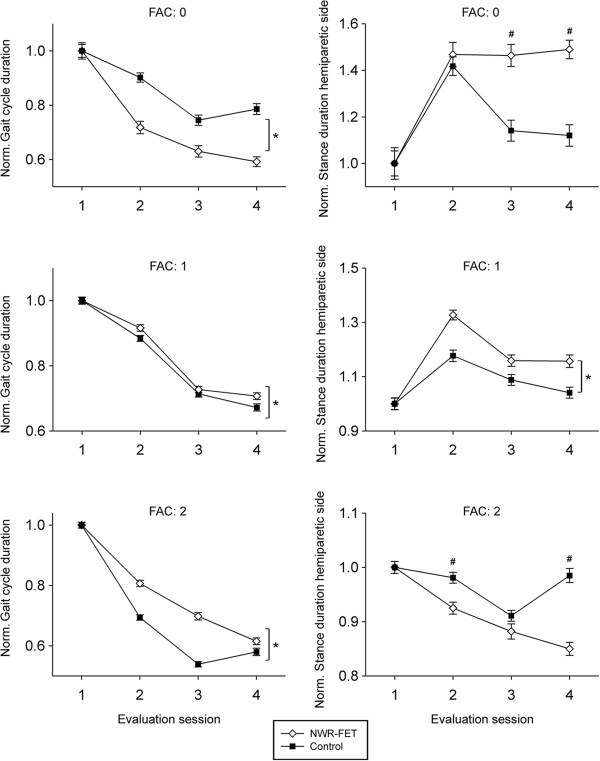
Gait cycle and Stance phase. Duration of the Gait cycle and of the Stance phase in the hemiparetic side stratified according to the FAC-test score at inclusion time (n = 5 for the NWR-FET and control groups for each FAC group). Values are normalized per subject to the mean at inclusion time to correct for differences at inclusion and shown at inclusion (evaluation 1), immediately after completion of training (evaluation 2), 1 month (evaluation 3), and 6 months (evaluation 4) after completion of training. Mean values at inclusion time are shown in Table 3. Asterisk indicates a statistically significant difference between groups after finishing treatment (p < 0.002). Square indicates a statistically significant interaction between group and evaluation session (p < 0.001).